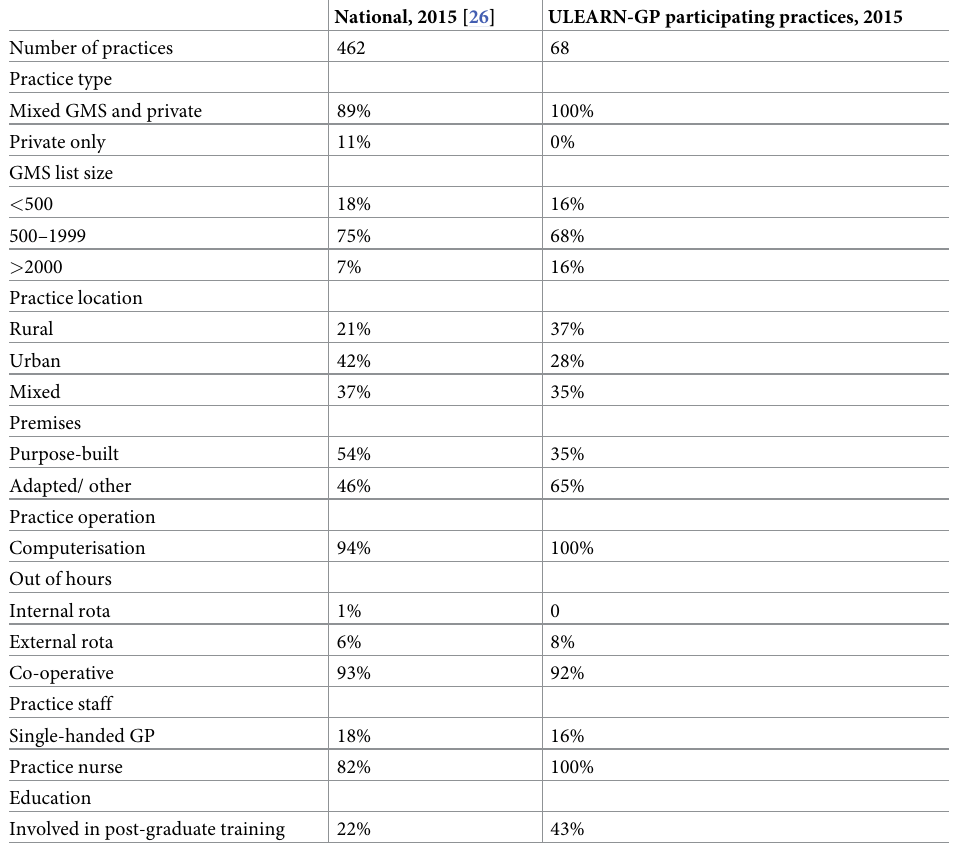
Table 1. Comparison of 2015 national profile to practice